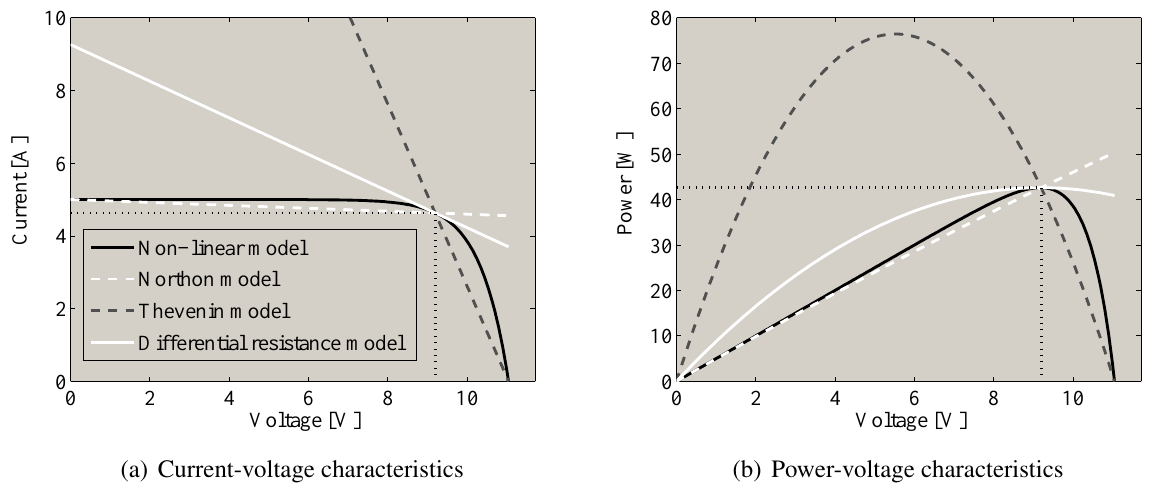
Figure 7. PVM linear models